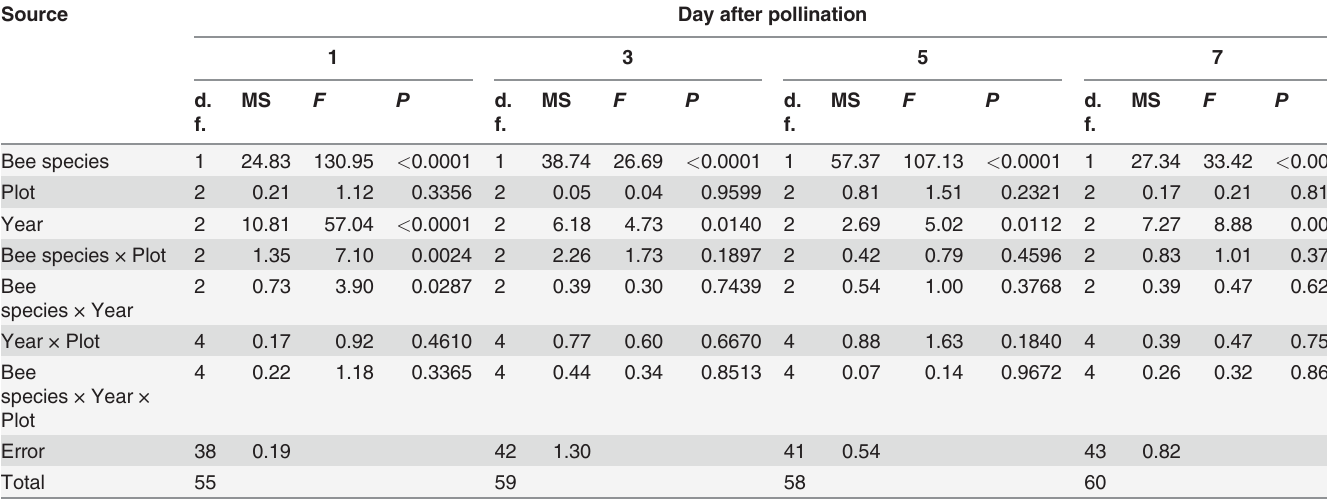
Table 1. General linear model of the effects of bee species, sample plot and year on pollen-tube growth along the style at each time after pollina- tion of peach under greenhouse conditions. Source Day after pollination